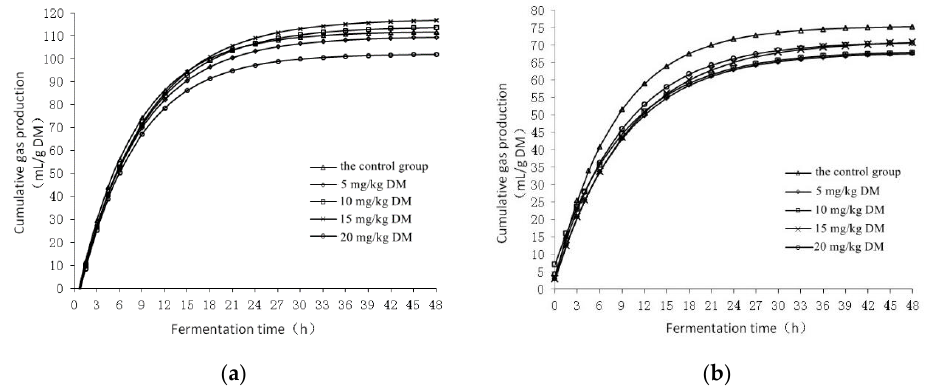
Figure 2. Cumulative gas production profiles of in vitro fermentation of substrates with LF ( a ) and HF ( b ) in response to increasing DON concentration expressed in µg/mL of culture fluid.